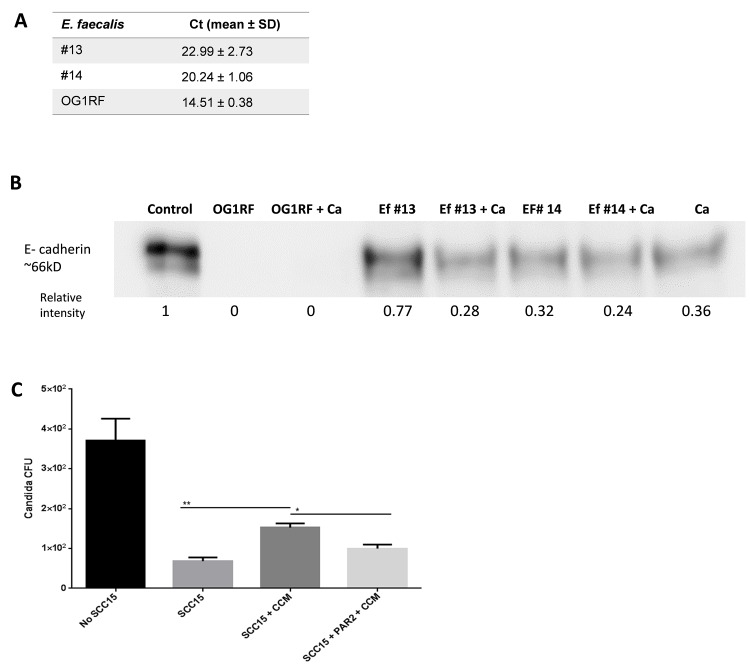
Enterococcus isolates from oral dysbiotic communities are able to degrade E-cadherin and promote epithelial permeability.A: Analysis of E. faecalis gelE gene expression by quantitative RT-PCR. Comparison of gene expression levels in stationary phase overnight cultures of isolates #13 and #14, with strain OG1RF used as a positive control. Relative RNA levels were calculated using the DDCt method and recA gene expression was used as an internal control to normalize RNA concentration. Data were expressed as mean threshold cycle (Ct) ± SD of duplicate samples in at least three independent cultures. B: E-cadherin degradation assay. Concentrated conditioned media from stationary phase cultures of E. faecalis isolates #13 and #14 were incubated with 3 μg of recombinant E-cadherin for 1 hour, with or without conditioned media from C. albicans SC5314. E. faecalis strain OG1RF was used as a positive control. Western blot shows reduction of E-cadherin signal with both isolated strains and complete degradation of the protein with strain OG1RF. Numbers under each lane represent relative image density as measured with the Image J software. One representative of three experiments is shown. C: Migration of C. albicans (SC5314) across confluent SCC15 cell monolayers in a transwell assay. Fungi translocating to the lower chamber after 4 hours incubation were quantified by plating the media for CFUs. C. albicans migration was significantly greater when monolayers were apically pretreated with E. faecalis Concentrated Cell Conditioned Media (CCM) compared to untreated or CCM+PAR2 inhibitor pretreated controls. Results are from 2 independent experiments with 3 technical replicates in each. Data are expressed as mean values and SEM. *p<0.05, **p<0.0001.